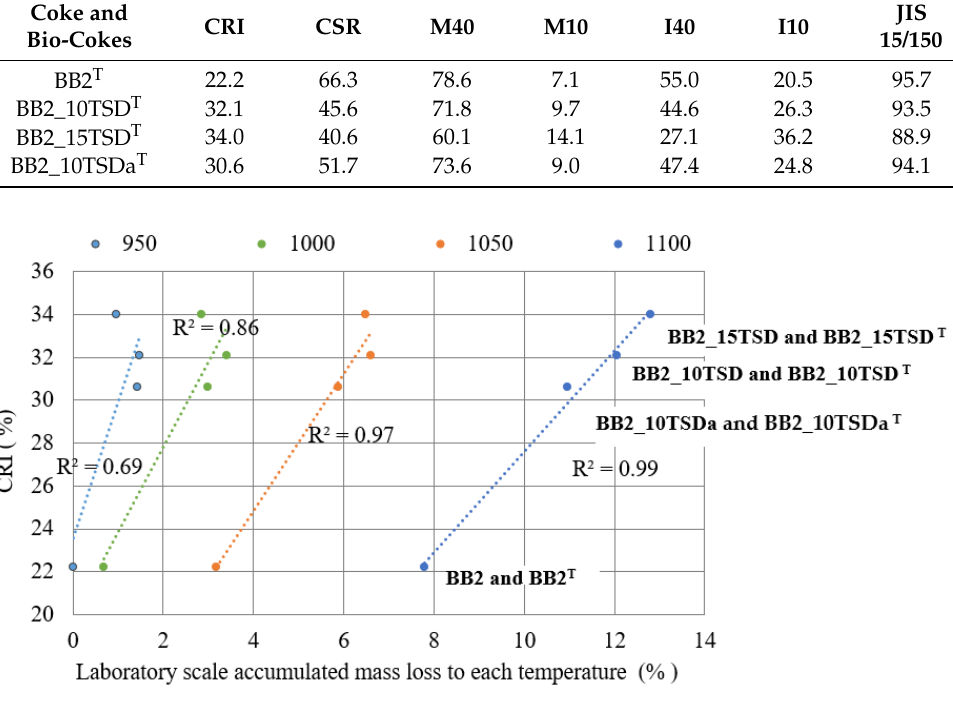
Figure 7. Correlation between CRI for coke produced in technical scale and mass loss up to 950, 1000, 1050 and 1100 °C in TGA tests for coke produced in laboratory scale.